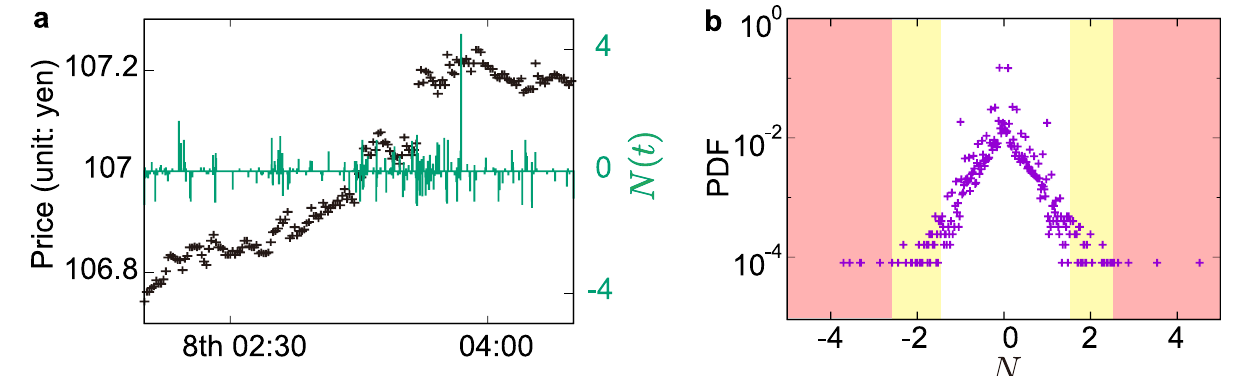
Fig 4. Statistical properties of signals N ( t ) recognizing outlier trades, defined by Eq 10. (a) Example of signals N ( t ) (green line) on top of the mid- price trajectory (black points). The abscissa represents the time from 2:10 to 4:20 on 8 June 2016. The left and right ordinates represent market prices and the magnitude of signal N , respectively. Positive (negative) signals show the end time of outlier trading for the buy (sell) side, and a large N ( t ) indicates that several banks concluded their outlier trades simultaneously. (b) Probability distribution function of N . We define extreme outliers as being in the bottom and top 0.05% (total 0.1%), highlighted by the translucent red boxes, and define moderate outliers as being in the top and bottom 2.5%, excluding the extreme outliers (total 4.9%), highlighted by the translucent orange